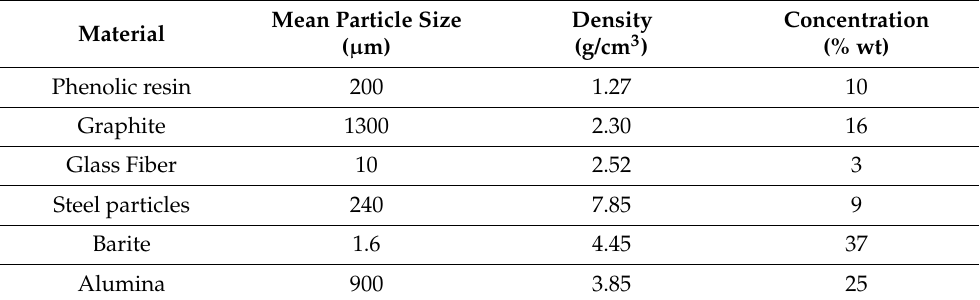
Table 1. Composition of the reference pad elements (in the composite PAD elements, the ELT rubber particles are subsequently added in the specified proportions to this reference pad).